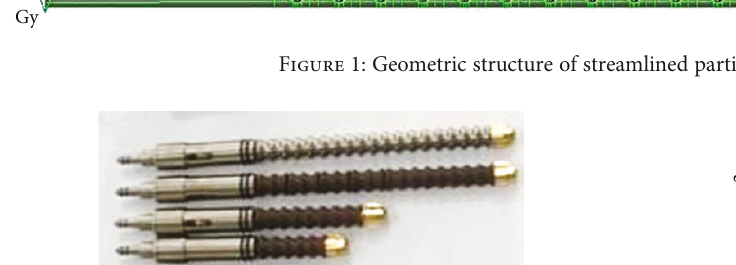
Figure 3: The size of the depressurizing channel in the experimental model.